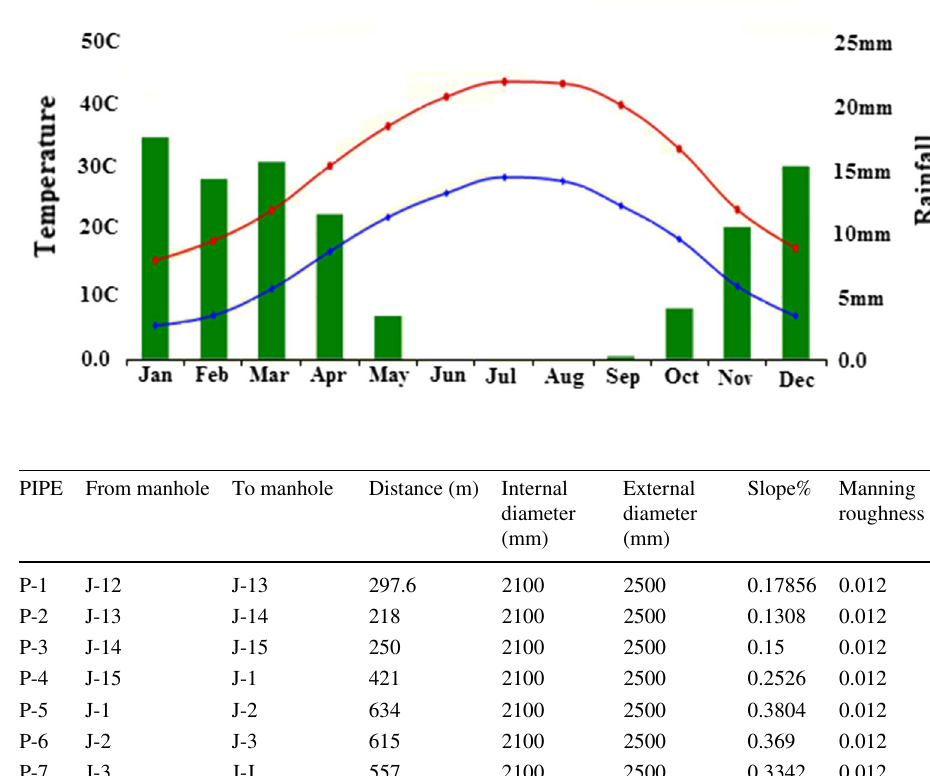
Fig. 3 The seasonal varia- tion of climate in Karbala city (1980–2013)